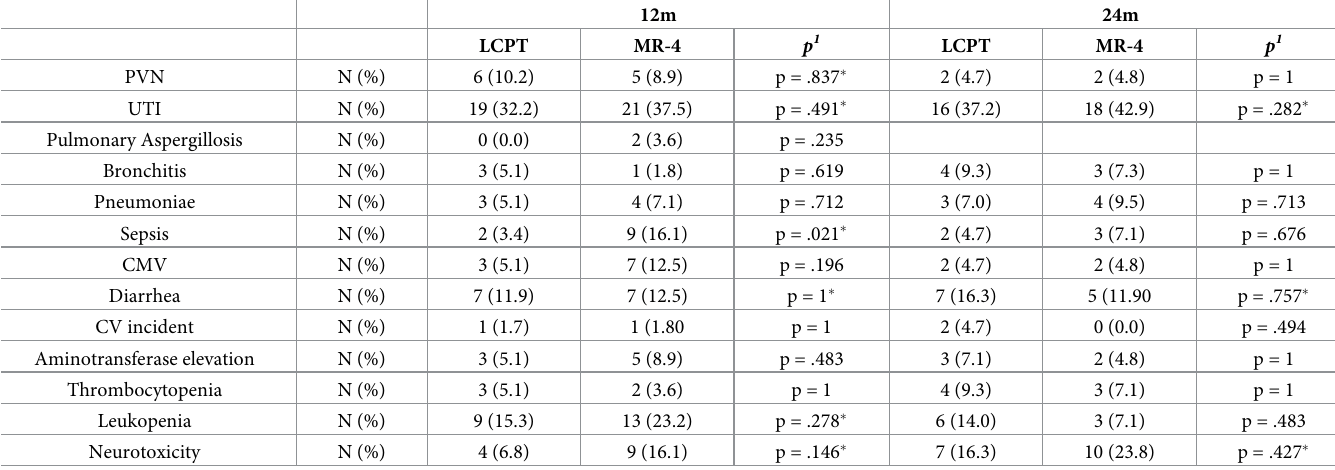
Table 5. Adverse events in LCPT and MR-4 group 12 and 24 months